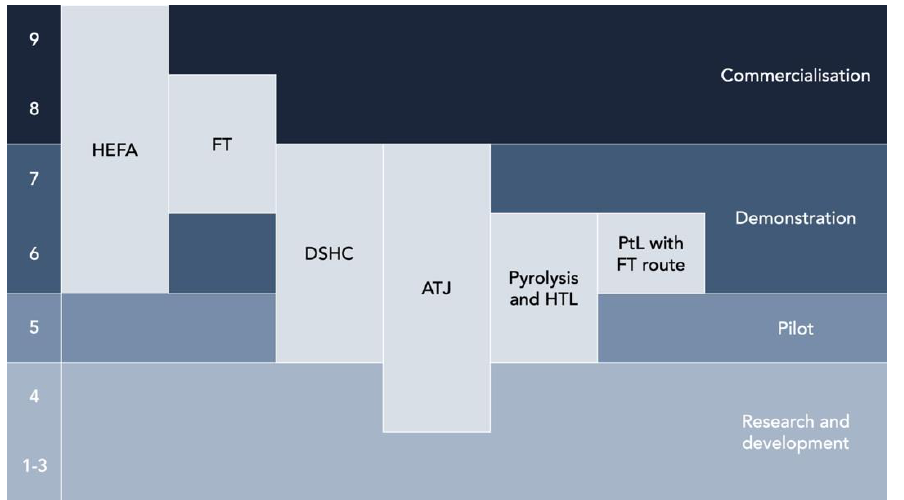
Figure 1. Technological readiness level of different conversion pathways from concept to commer- cialization. Modified from source: de Jong [42] with Power-to- liquid (PTL) added from O’Connell et al.